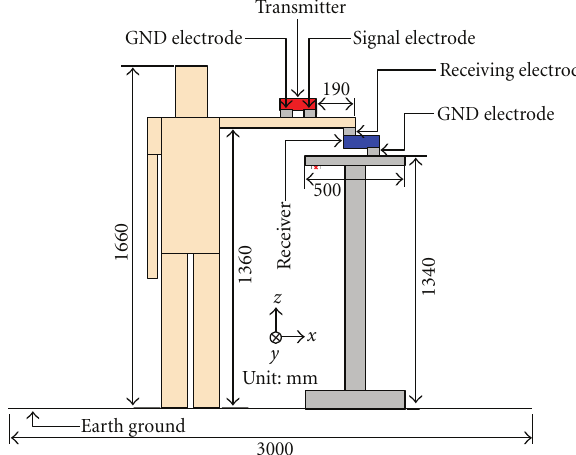
Figure 9: Calculation model of developing a closed circuit through the earth